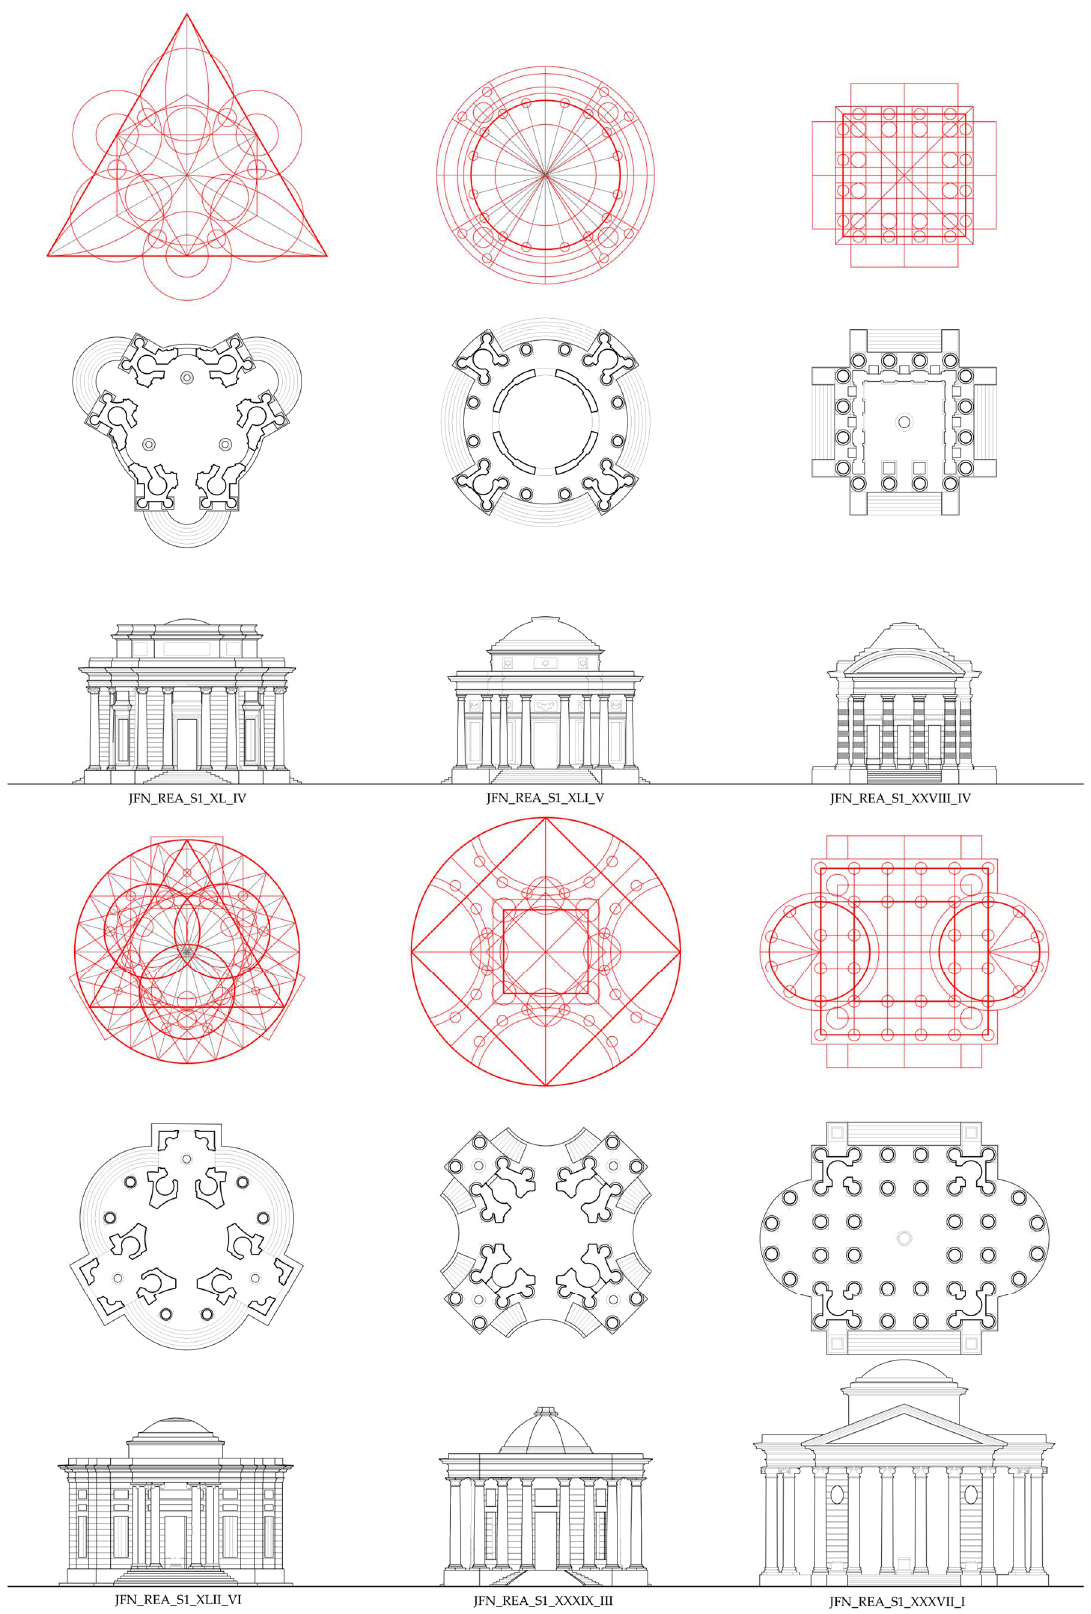
Figure A4. Partial taxonomy of independent buildings for a geometrical-formal